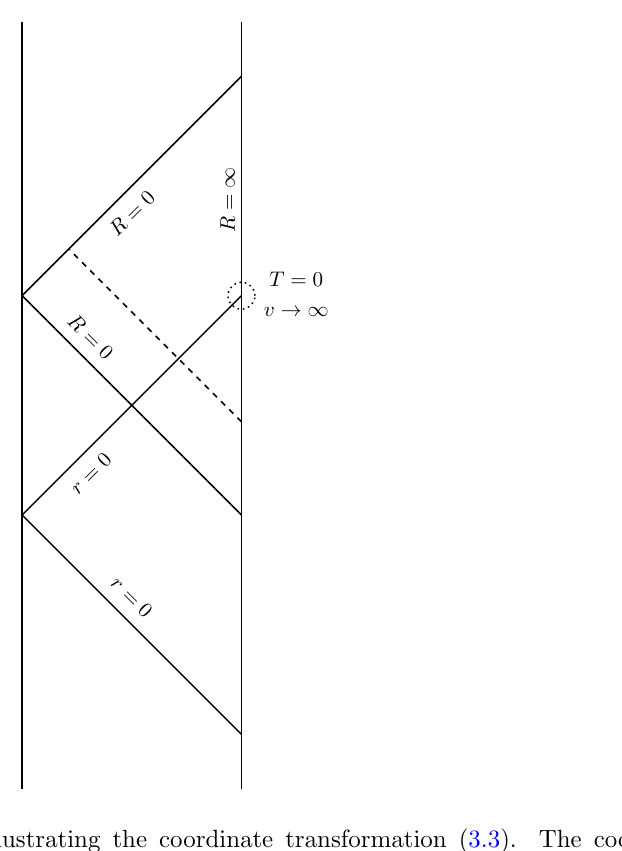
t, r, χ cover the lower triangular { } or r = 0, v t 1 /r , on which we focus, is indicated by the ∞ ≡ − → ∞